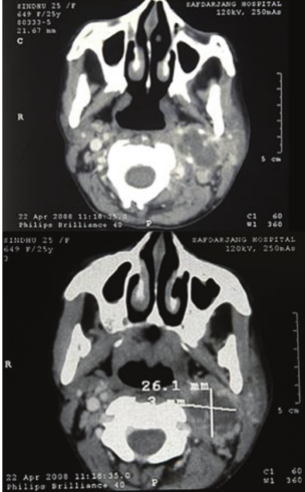
Figure 3: CT scan showing IJV thrombosis with carotid